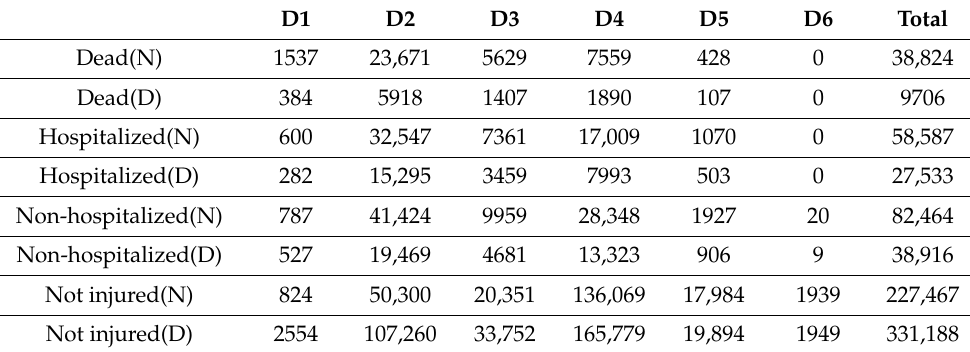
Table 12. Number of casualties in the 1721 earthquake in District 3 of Tabriz.